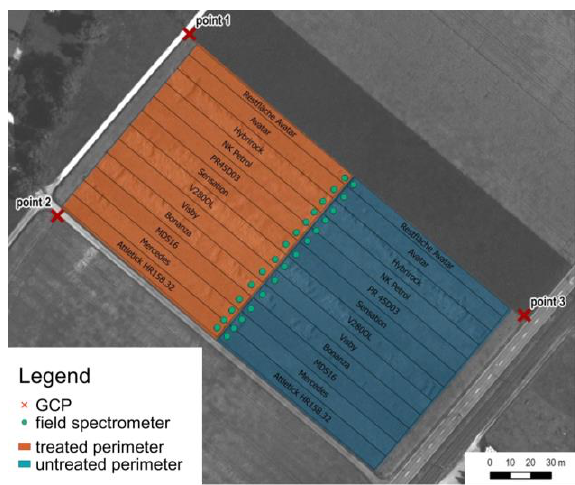
Figure 4. Rape species study with fungicide treatment (orange, left) and without treatment (blue, right).